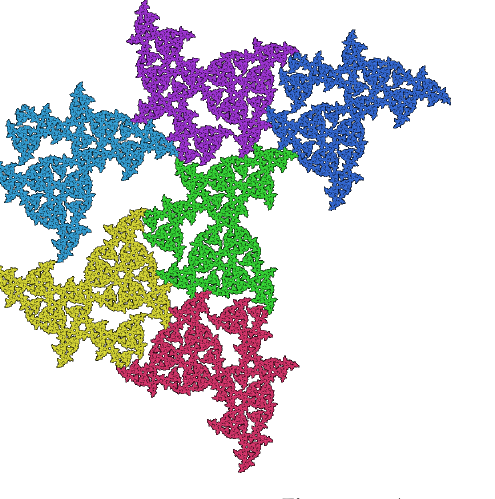
together with 60 ◦ rotations. 13